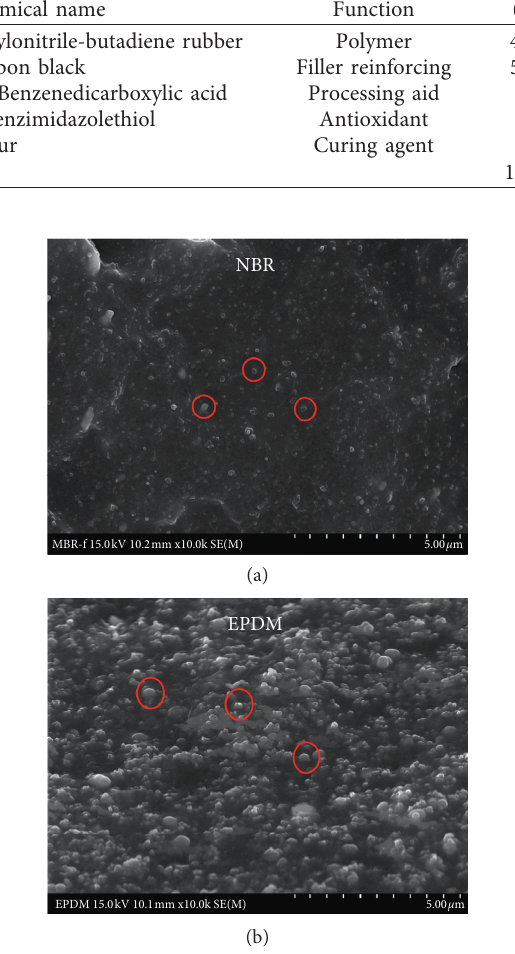
Figure 2: The SEM image of NBR and EPDM rubber. (a) The image of a carbon black filler in the NBR rubber and (b) a carbon black filler in the EPDM rubber. The scale bar of both figures indicated is 5 μ m. The red circles in both figures indicated the aggregate form of the carbon black